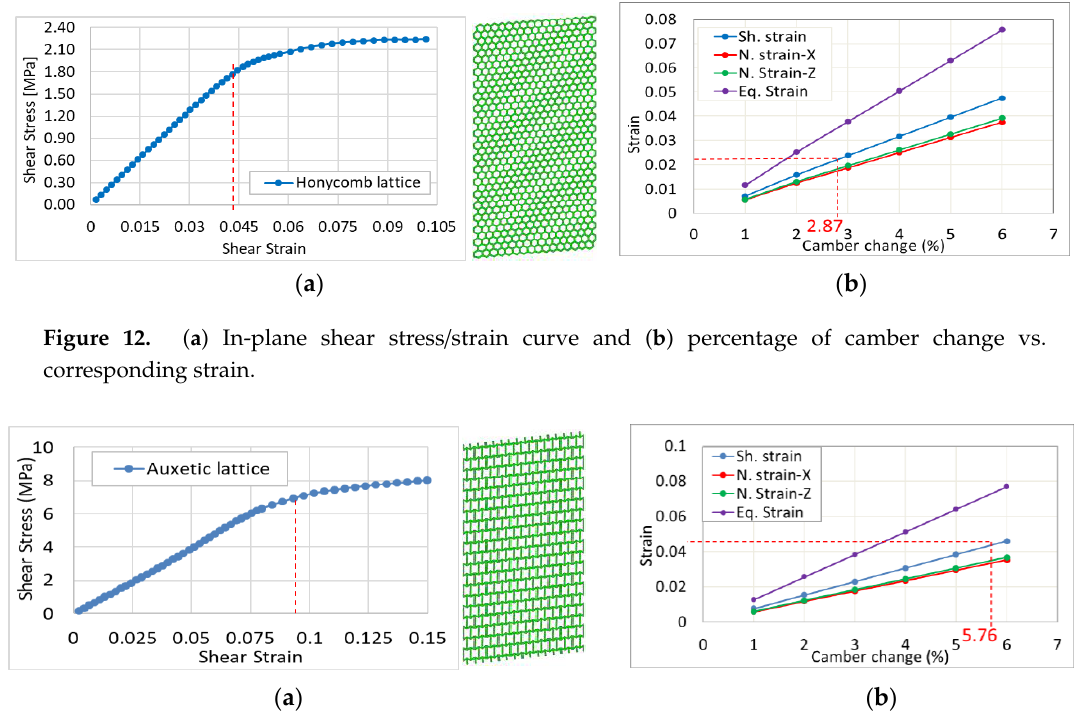
Figure 12. ( a ) In-plane shear stress/strain curve and ( b ) percentage of camber change vs. corresponding strain.